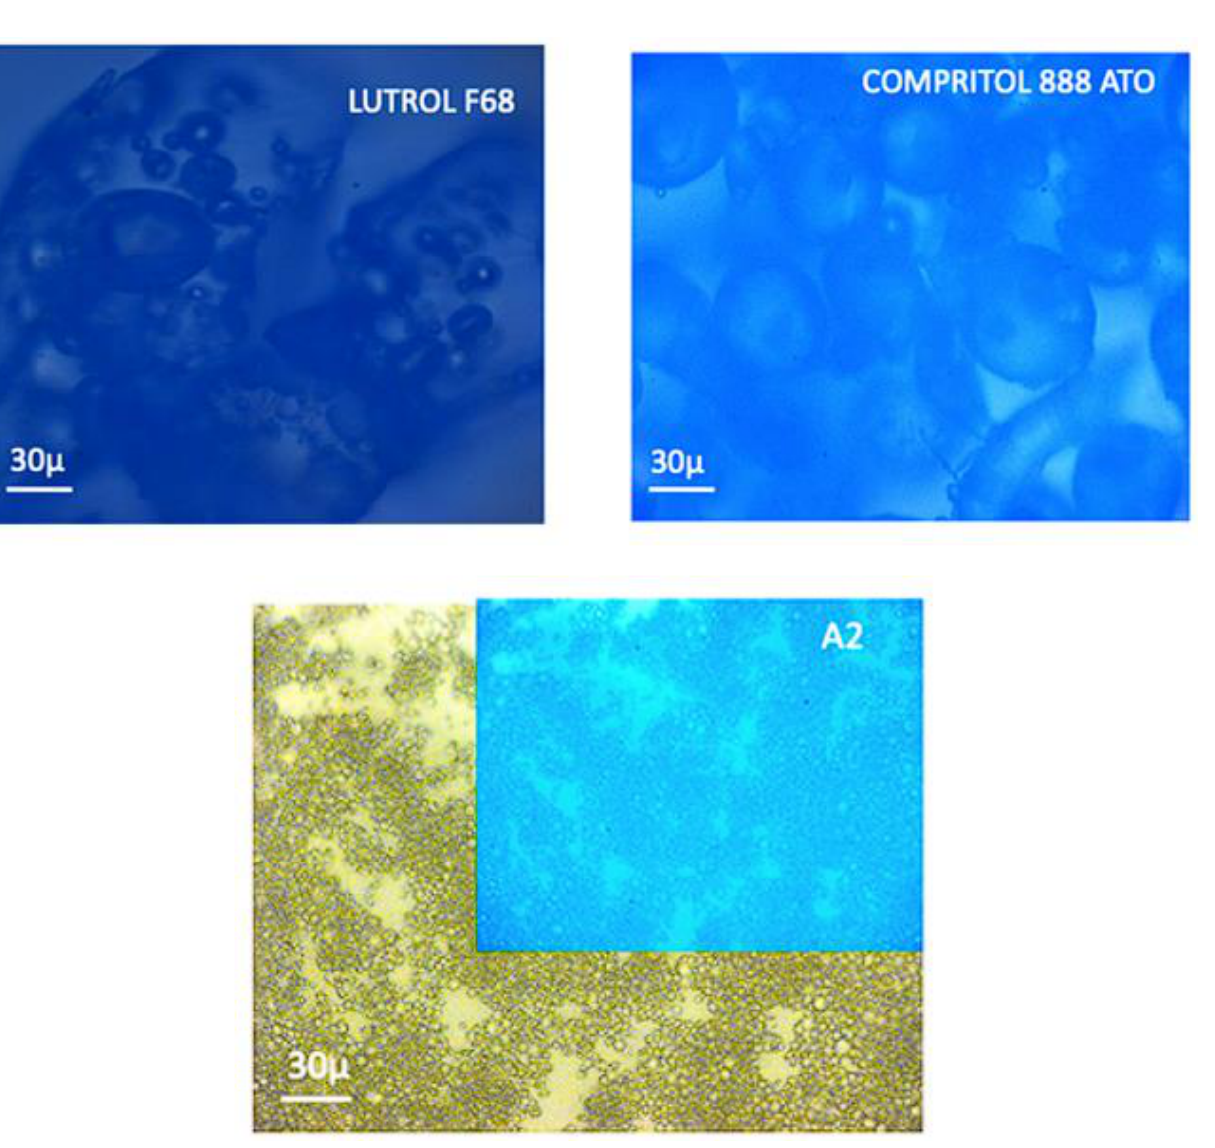
Figure 1. Fluorescence microscopy (FM) micrographs of raw materials, Lutrol F68 and Compritol 888 ATO ( 4′,6 -diamidino-2-phenylindole; DAPI, 40×) and A 2 batch (DAPI, blue image, and brightfield, 40×).